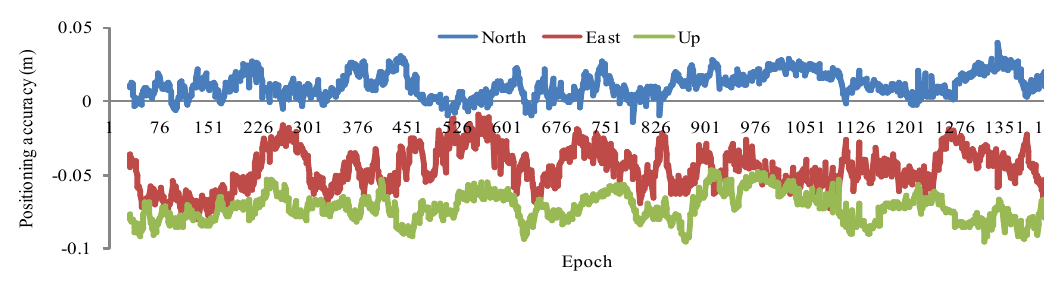
Figure 6. SDED & ED combined kinematic PPP